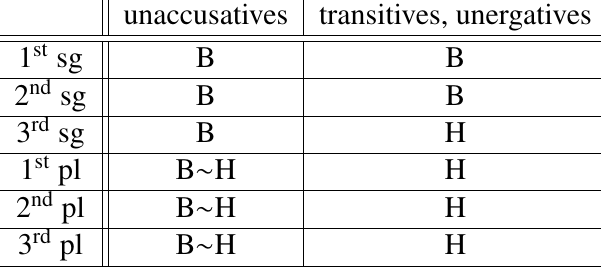
Table 2: Auxiliary selection in Pietransieri (Loporcaro, 2007, p.